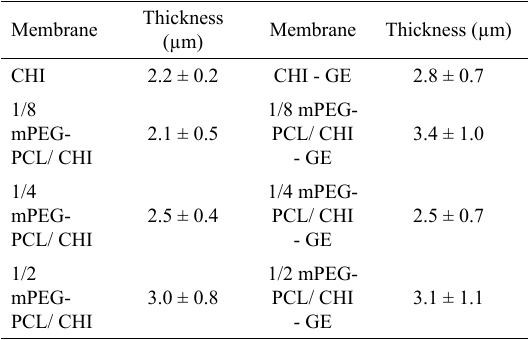
Table 2. Average thickness (µm) of membranes unloaded and loaded with gentamicin.